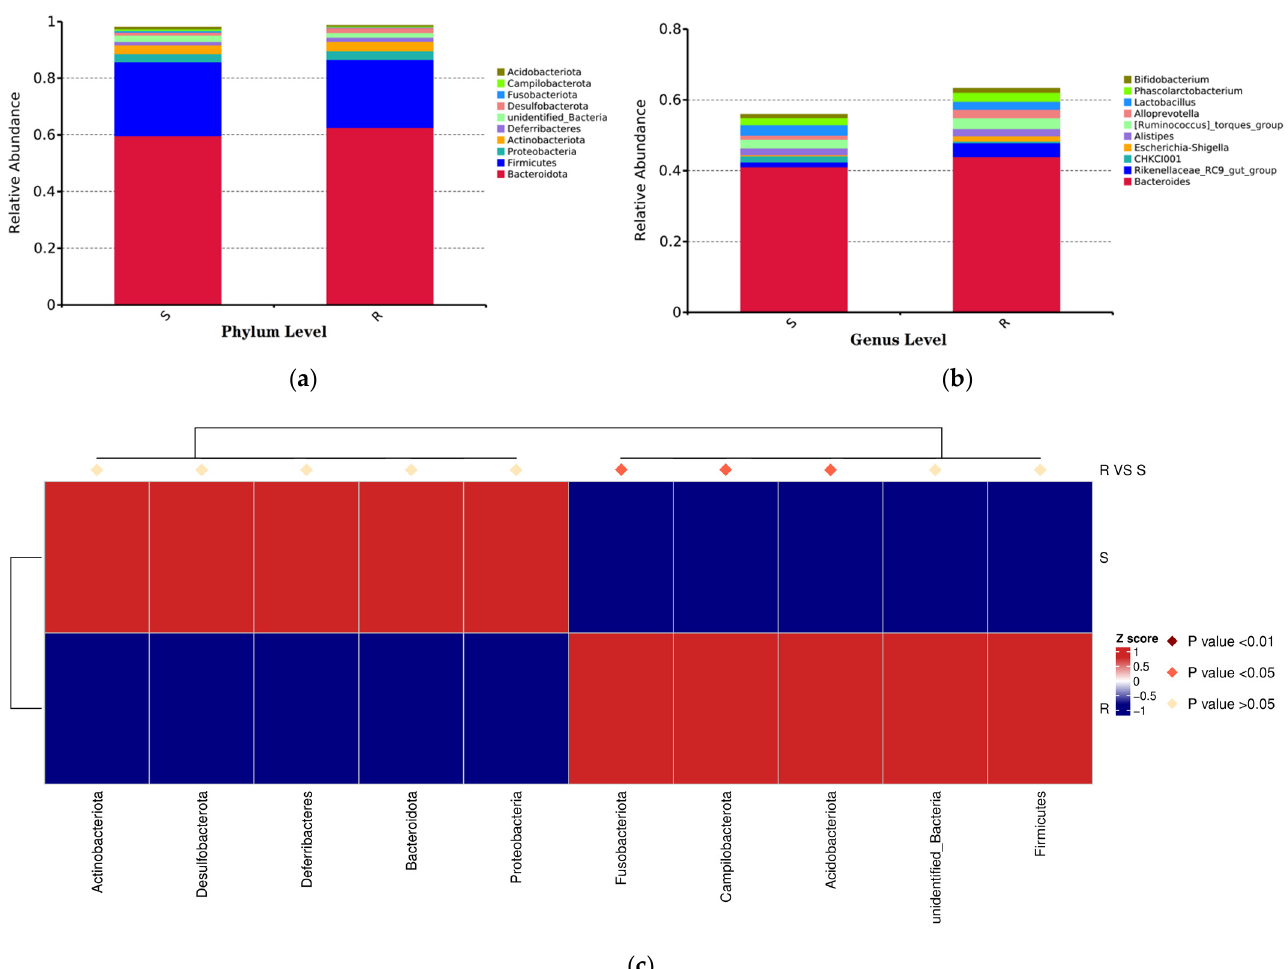
Figure 4. Changes in microbial composition and structure at the phylum and genus levels ( n = 8). ( a ) Top 10 microbial populations at the phylum level. ( b ) Top 10 microbial populations at the genus level. S = selected S. enteritidis -susceptible chicks; R = selected S. enteritidis -resistant chicks. ( c ) Complex heatmap of the top 10 microbial populations at the phylum level.